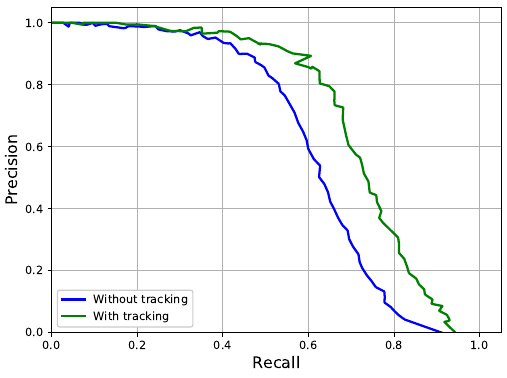
Figure 6. Comparison of results with and without